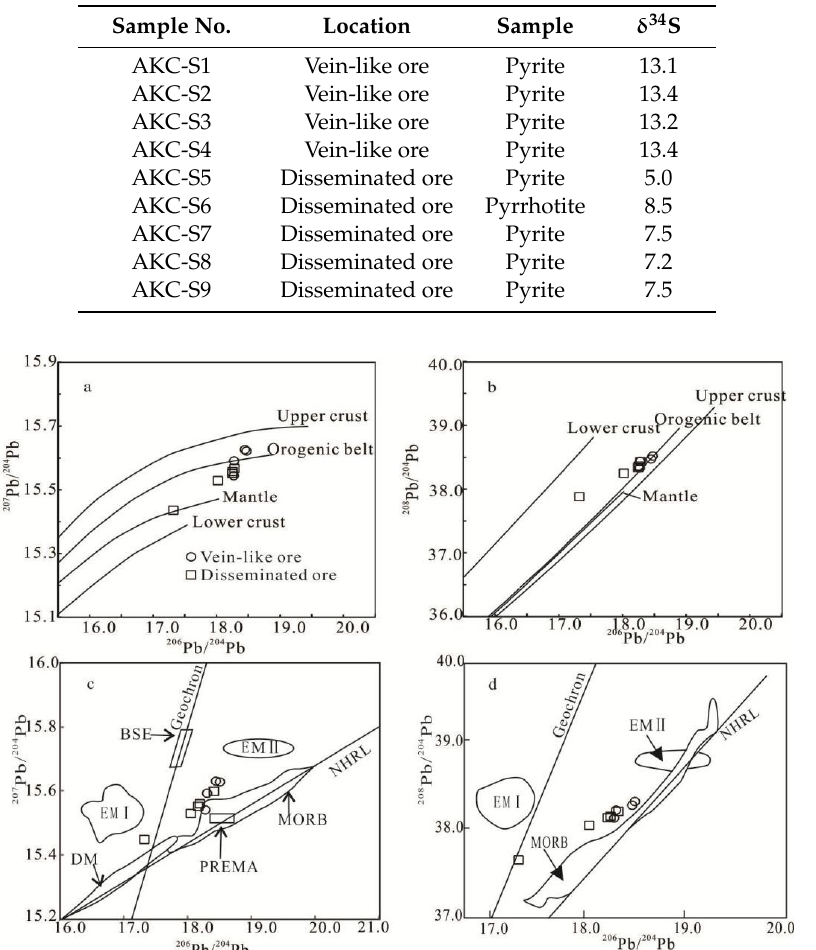
Figure 9. Diagrams of 206 Pb/ 204 Pb, - 207 Pb/ 204 Pb, and 206 Pb/ 204 Pb - 207 Pb/ 204 Pb of the sulfides from Akechukesai Ⅳ mafic–ultramafic complex. EM Ⅰ : enriched mantle Ⅰ ; EM Ⅱ : enriched mantle Ⅱ ; MORB: mid-ocean ridge basalt. Data sources: Zart and Doe [24], Allegre et al. [25], Zindler and Hart [26].